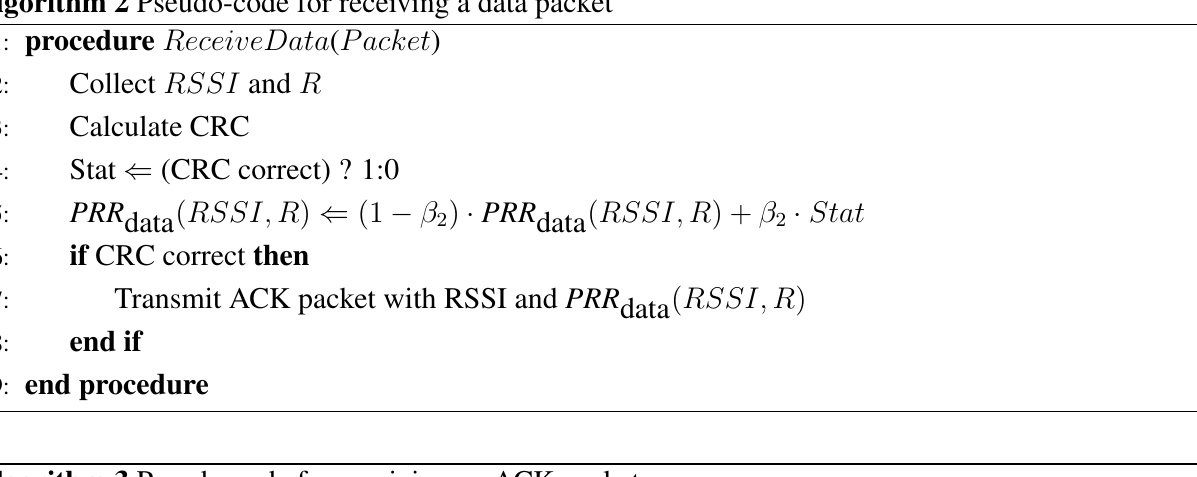
Algorithm 3, Line 14 statistically estimates P RR PRR is calculated in Line 15. ack Algorithm 2 Pseudo-code for receiving a data packet